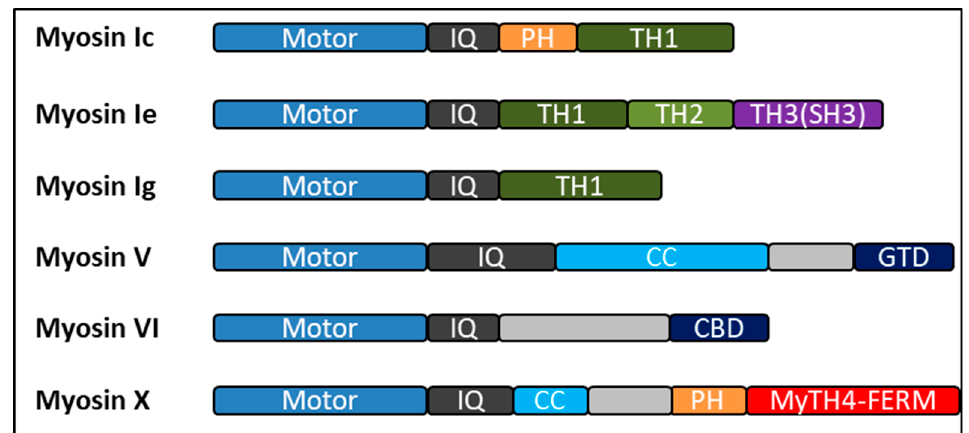
Figure 1. Bar diagrams showing the overall architectures of human myosins discussed in this review. All the myosins have conserved motor heads (blue), di ff erent numbers of IQ motifs (gray) followed by a distinct tails with various functional domains. Colored boxes represent di ff erent regions predicted by sequence homology: PH, pleckstrin homology domain; TH1, TH2, and TH3, tail homology region 1, 2, and 3; CC, coiled-coil domains; GTD, globular tail domain; CBD, cargo binding domain; SH3, Src-homology 3 domain. Myosin-Va, and myosin-X exist as constitutive dimers and myosin-VI may exist in both monomeric and dimeric forms.